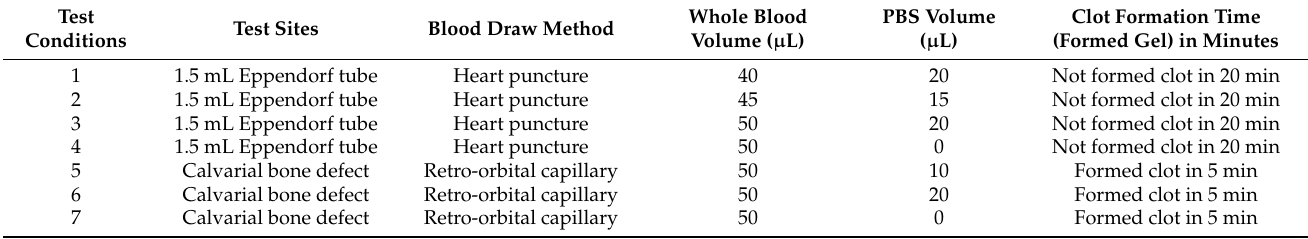
Table 1. Clot formation test conditions and results.